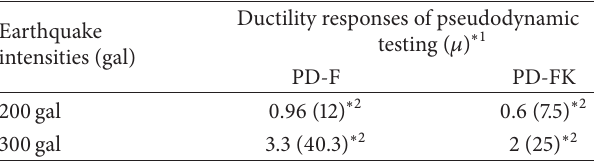
Table 7: Comparison of response